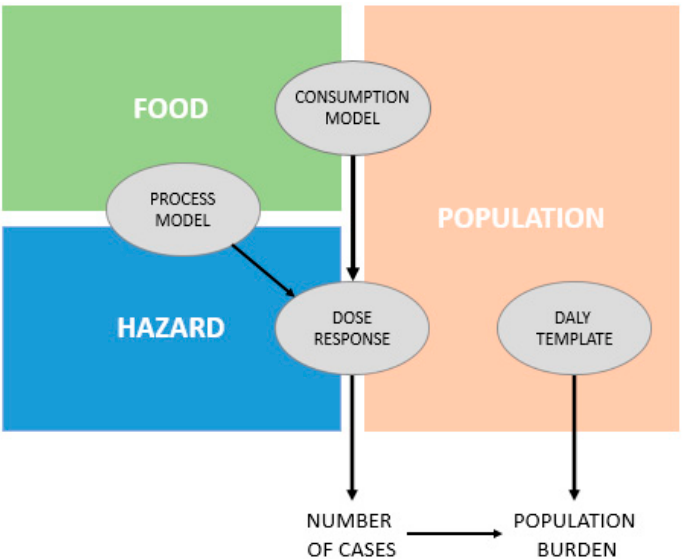
Figure 4. The seven elements of FDA-iRisk and their relationships in a generic risk scenario (modi- fied from fi ed from [31]).